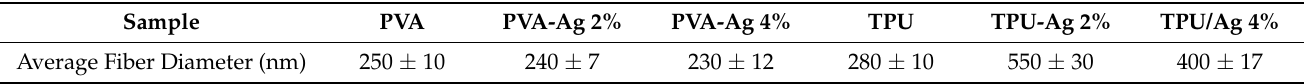
Table 1. Average fiber diameter distribution of PVA and TPU nanofibers.